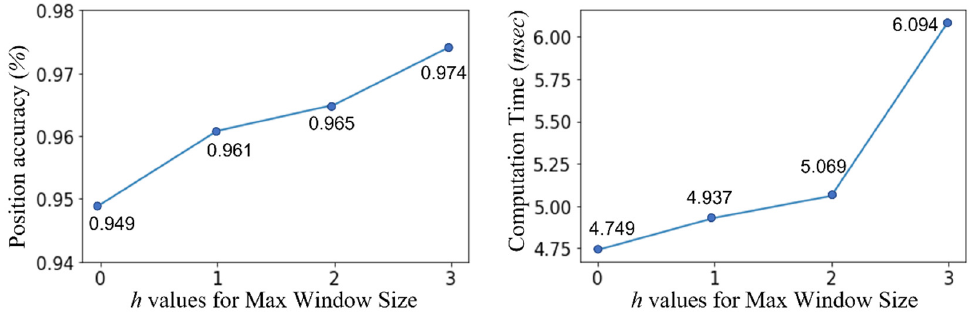
Figure 13. Results of average accuracies for position recognition and spent computation time according to the increment of maximum window size, h , through the testbed.